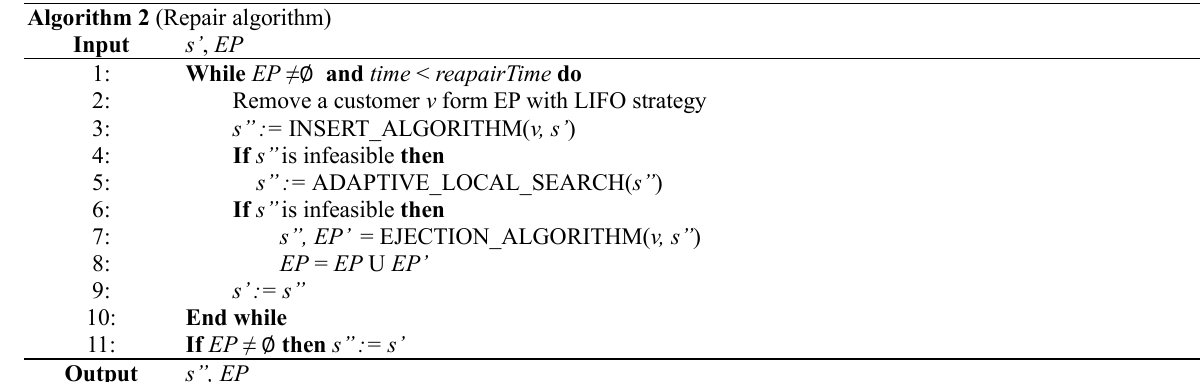
Algorithm 2 (Repair algorithm)